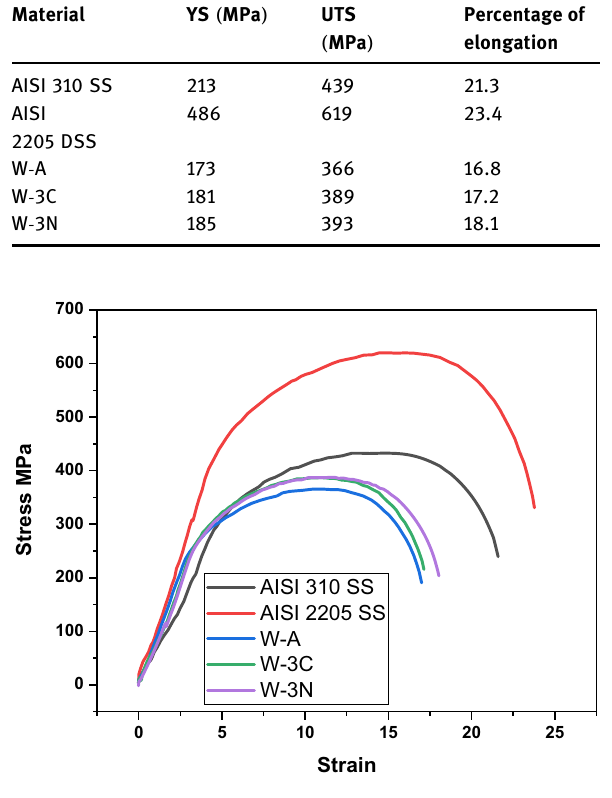
Figure 3: Stress – strain graphs of tensile - tested specimens.